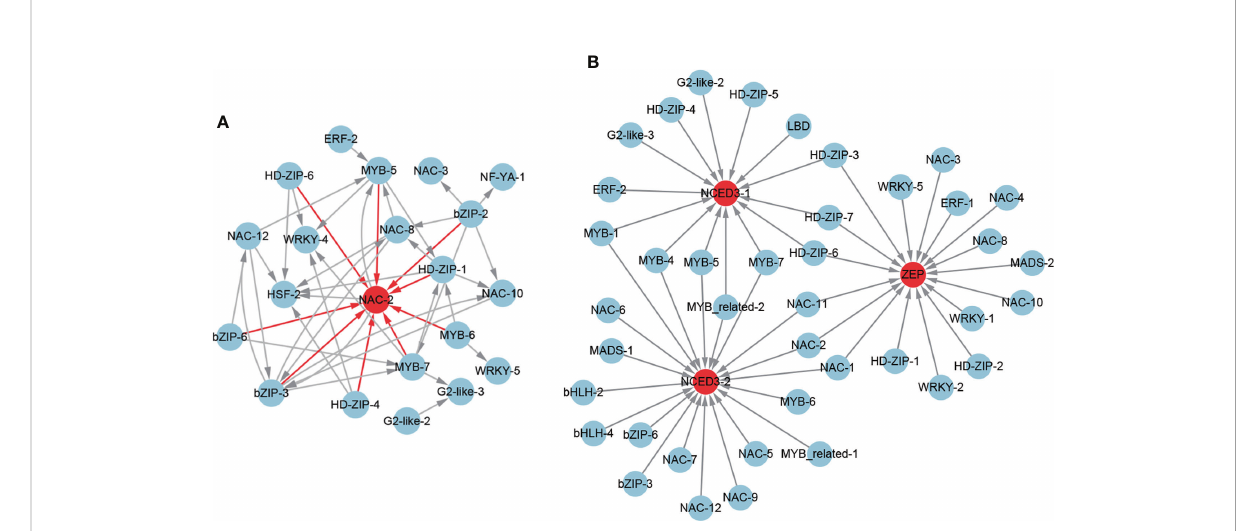
FIGURE 10 The regulatory network of ABA-responsive TFs (A) and ABA biosynthesis genes (B) from the core drought-resistant genes in